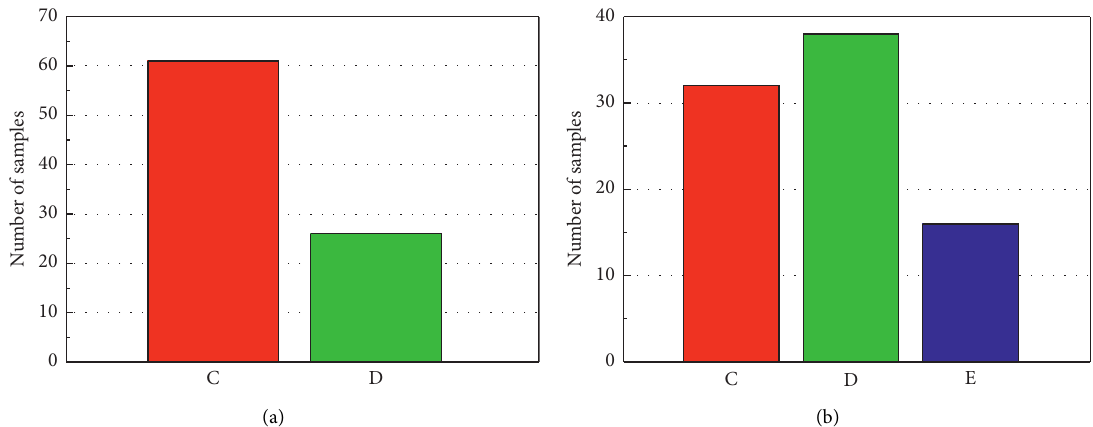
Figure 6: Numbers of samples in each site class. (a) Near-fault pulse-like ground motions. (b) Far-field harmonic ground